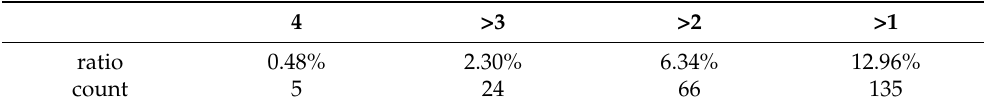
Table 6. The ratio and count of actual nonrepresentative spatio-temporal documents to be judged as nonrepresentative spatio-temporal documents according to